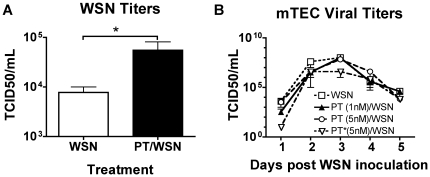
Effect of PT on influenza WSN virus infection in BALB/c mice and on mTECs.(A) Groups of BALB/c mice (n = 4) were pretreated with 100 ng of PT or an equal volume of PBS and 24 h later inoculated with 500 PFU of influenza WSN virus. Mean pulmonary viral titers were determined 3 days post virus inoculation. (B) mTECs (3 wells per group) were treated with 1 nM or 5 nM PT or 5 nM PT* for 24 h, or left untreated. The cells were then washed and infected with WSN virus at an MOI of approximately 0.001. After 1 h incubation, the inoculum was removed, and the cells were washed with medium and incubated at 37°C. At the indicated times, the infected-cell supernatant was sampled, and infectious virus titers were determined by TCID50.